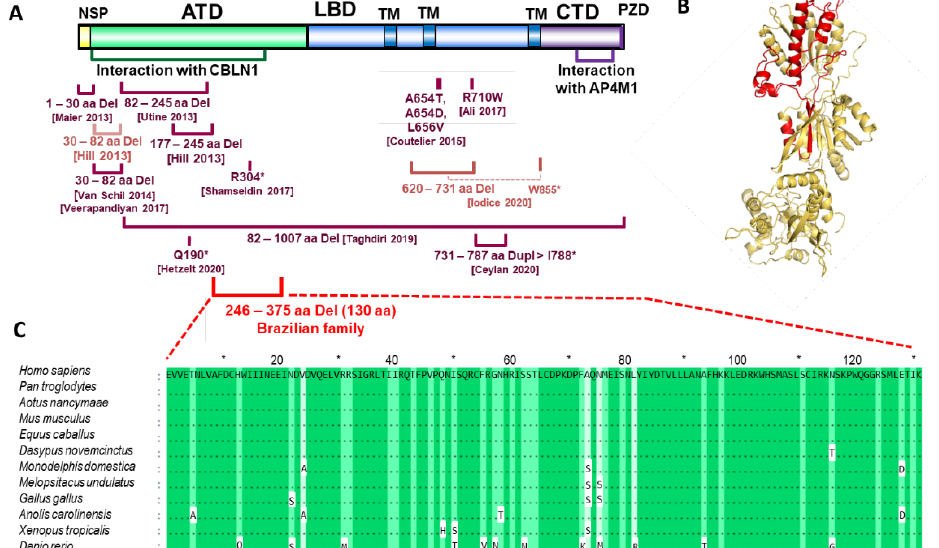
Figure 3. Representation of deleted region in glutamate receptor delta 2 ( GRID2 ): ( A ) The glutamate receptor delta 2 precursor consists of N-terminal signal peptide (NSP), extracellular amino-terminal (ATD), ligand binding domain (LBD), 3 transmembrane domains (TMs), and C-terminal intracellular domain (CTD) with PZD domain [55]; protein structure created using IBS [56]. Pathogenic variants are indicated in reported family cases: in red—deletion of exons 5–7 encoding a part of ATD found in Brazilian patients; in dark red—homozygous variants (Del—deletions, Dupl—duplications, nonsense, and missense) reported previously in other studies; in light red—heterozygous variants (compound variants joined by broken line, reported previously in other studies); *—stop codon; ( B ) the prediction of spatial structure of GRID2 receptor monomer (NP_001501.2) via Phyre2 was visualized using Pymol software. Deleted region contains part of a large extracellular alpha chain domain and one beta strand (marked in red); ( C ) deleted region conservation across animals visualized in GeneDoc program [57]; evolutionary conserved amino acids are indicated in green. Protein CDSs were obtained from the NCBI nucleotide database and aligned using the MEGA6 software